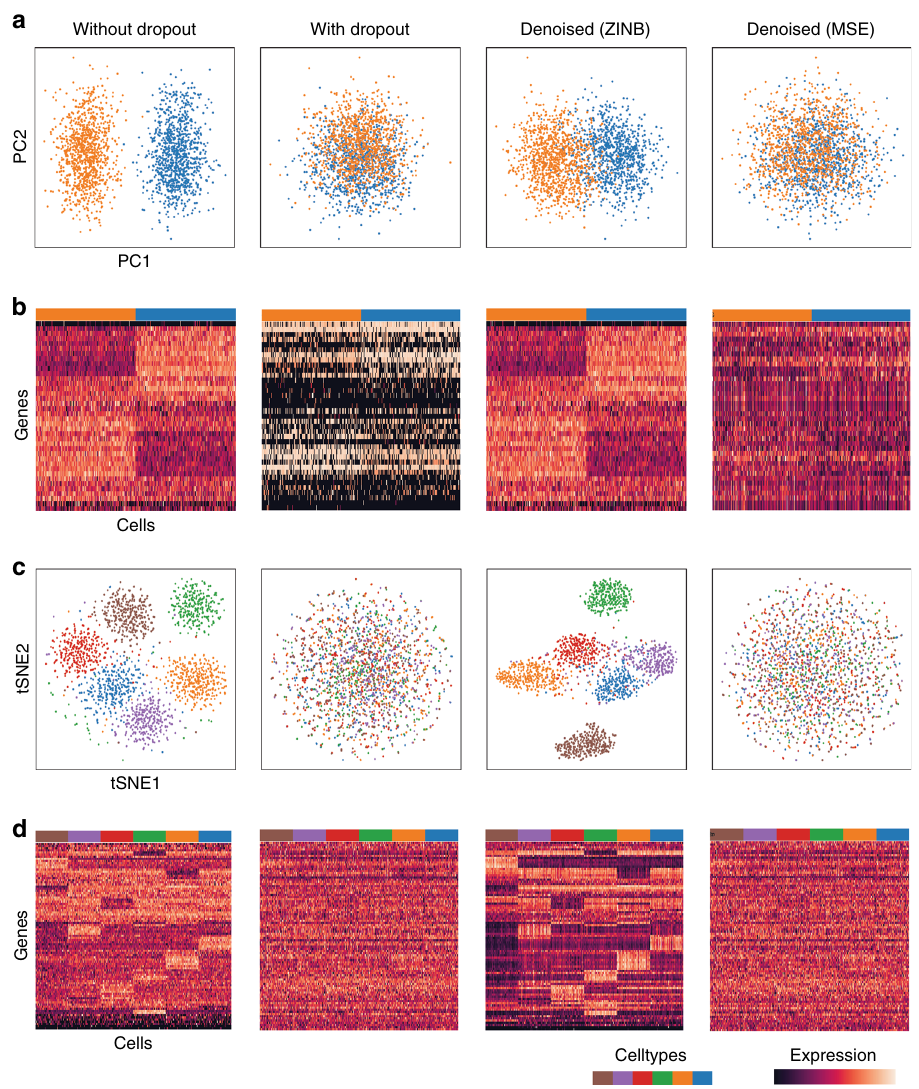
Fig. 2 Count-based loss function is necessary to identify celltypes in simulated data with high levels of dropout noise. a depicts plots of principal components 1 and 2 derived from simulated data without dropout, with dropout, with dropout denoised using DCA and MSE based autoencoder from left to right. Cells are colored by celltype. b shows heatmaps of the underlying gene expression data. c illustrates tSNE visualization of simulated scRNA-seq data with six cell types. Cells are colored by celltype. d shows heatmaps of the underlying gene expression